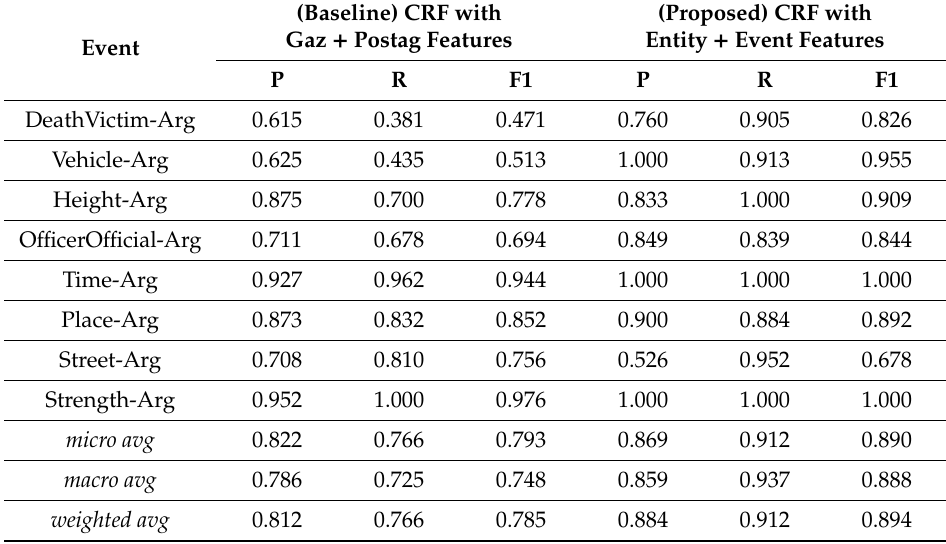
Table 8. Argument extraction performance (step 4).